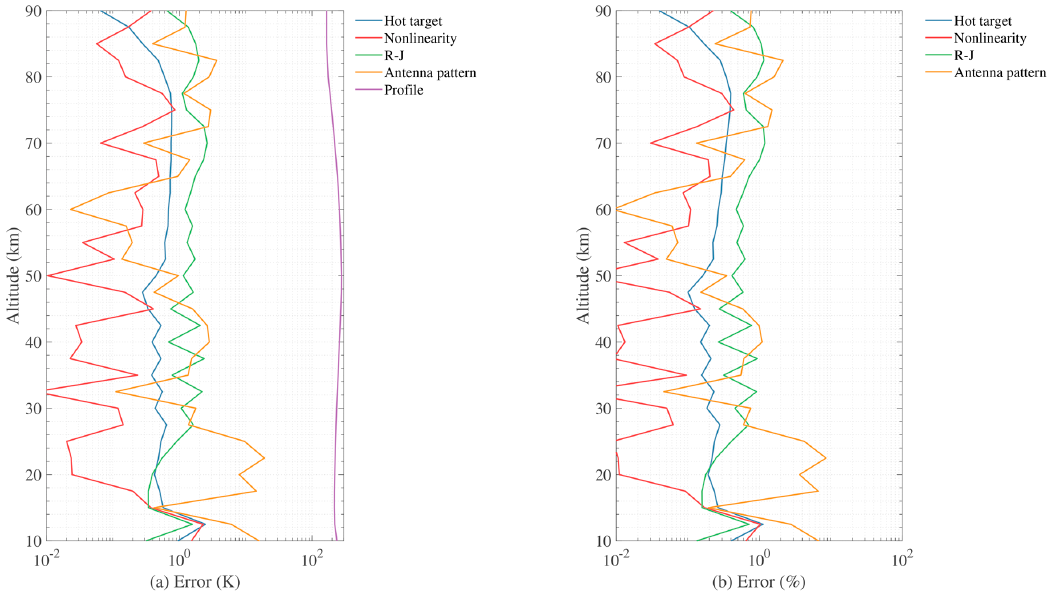
Figure 7. The temperature retrieval errors induced by different calibration error sources: ( a ) absolute and ( b ) relative retrieval errors. The uncertainties assumed are summarized in Table 4.